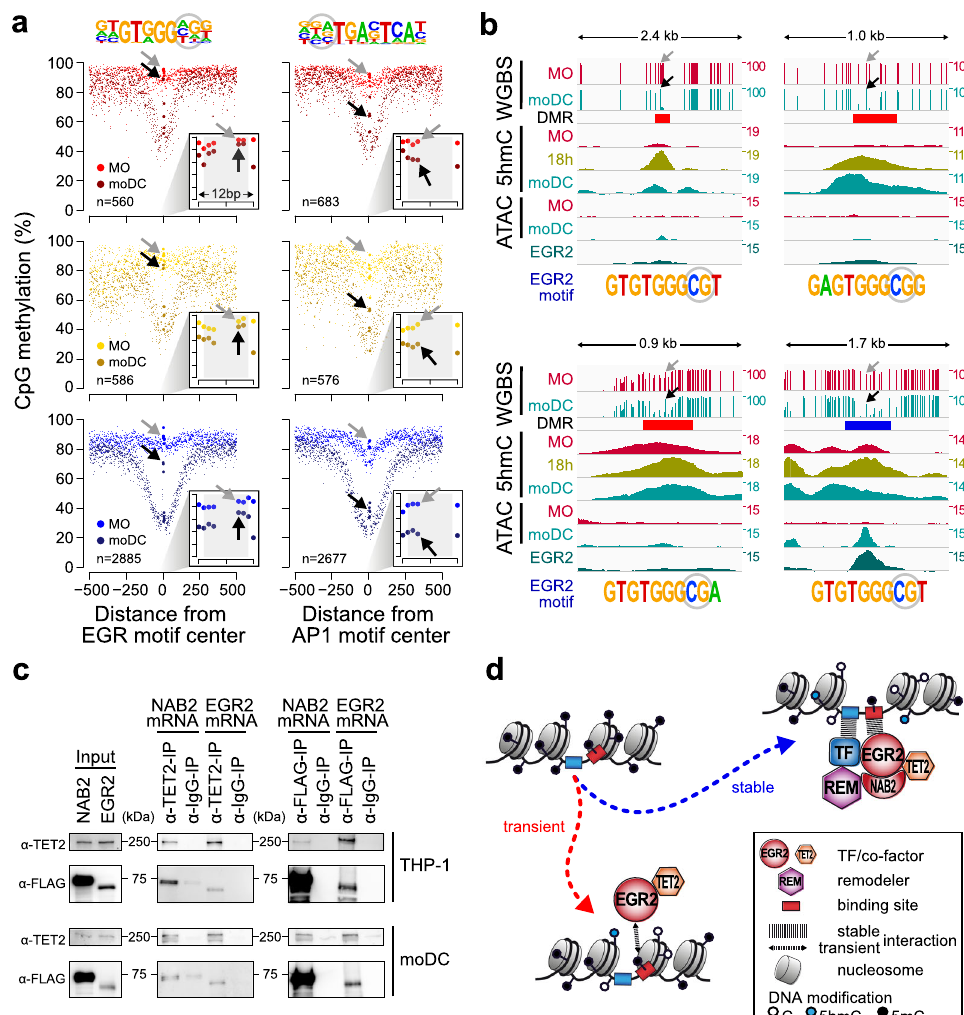
Fig. 6 Methylation footprint and TET2 interaction of EGR2. a Genomic distance distribution of averaged DNA methylation ratios in MO and moDC across “ TF peak ” , “ open ” , and “ no peak ” groups (in blue, yellow, and red, respectively, as de fi ned in Fig. 3c) of DMR demethylated in moDC. DMR were centered on the consensus EGR (left panel) or AP1 motifs (right panel), which are shown on top of each panel (CpG positions that are highlighted by arrows in gray (MO) and black (moDC) in the lower panels are circled). Each panel shows the distribution of DNA methylation ratios across a 1-kb window (large graph) as well as a 12-bp window focusing on the motif-covered CpGs only (smaller inlay graph in the bottom right corner). The number of motifs containing DMR is given in the lower left corner of each panel. b IGV genome browser tracks of example loci showing single CpG methylation ratios (WGBS), 5hmC and ATAC-seq coverage in MO and moDC, and EGR2 ChIP-seq coverage in moDC. Genomic locations of DMR are shown (coloring according to the classi fi cation into DMR groups “ no peak ” or “ TF peak ” in red or blue, respectively). EGR motif sequences are given below each track and arrows in the top tracks mark the positions of the circled CpG. c CoIPs of EGR2 or NAB2 (expressed as FLAG-tagged proteins via mRNA electroporation) and TET2 in THP-1 and moDC. Results are representative of two independent experiments. d Model of EGR2-induced DNA demethylation at transient and stable binding sites in moDC. ( a , c ) Source data are provided as a Source Data fi